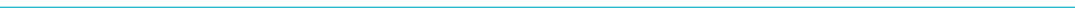
Figure 3: Age-standardised mortality rates (ASMR) (European standard [32]) per 100 000 person-years of amenable causes by sex for the population of 17 high-income countries, age 0–74 years, time periods 1997/1998 and 2006/2007.All results in this figure, other than those for Switzerland, are based on figures published by Nolte and McKee (2011) [18]. Unlike the present study, Nolte and McKee did not treat amenable causes and ischaemic heart disease (IHD) separately. Instead, 50% of deaths caused by IHD were classified as amenable. Based on the published figures, the rates of amenable conditions and IHD were recalculated to enable an isolated consideration of amenable and deaths caused by IHD. For countries with populations <10 million, rates are based on combined years (Austria, Denmark, Finland, Ireland, New Zealand, Norway, Sweden and Switzerland). For simplicity, this is referred to as combined years, with 1997/1998 as the starting point and 2006/2007 as the end point of the period under review. The sequence reflects the order based on the results of